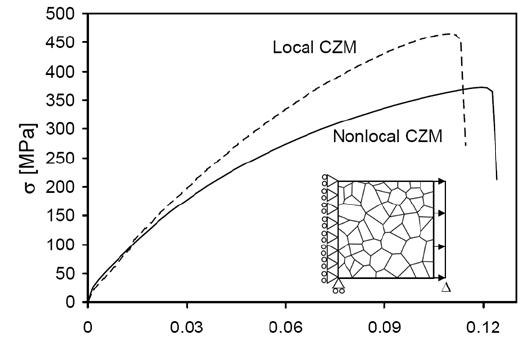
Figure 10: Homogenized stress-strain curve. The nonlocal CZM response (with stochastic distribution of interface properties) is compared with the prediction of the local CZM by Tvergaard with the same fracture energy for all the